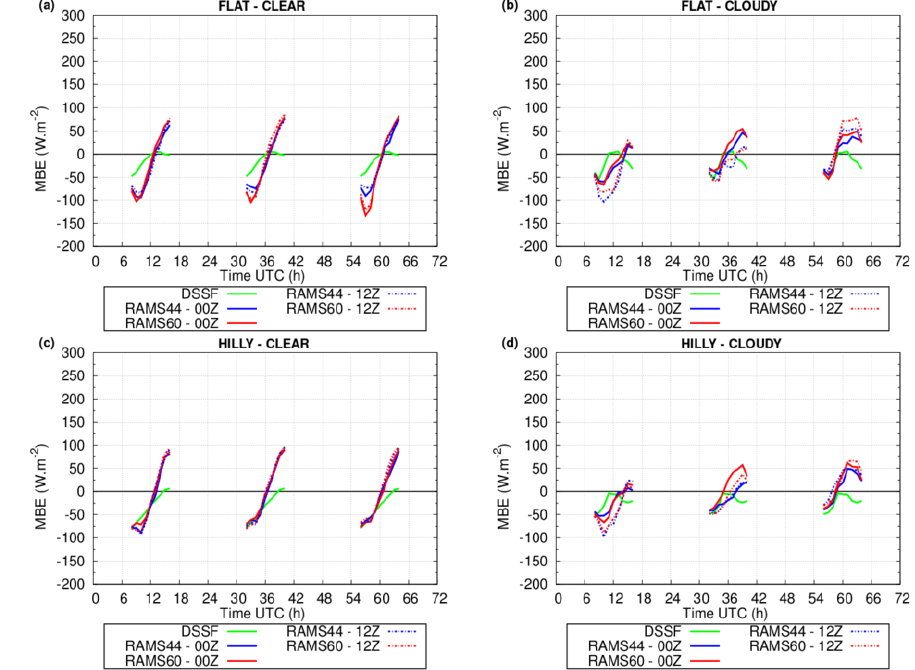
Figure 7. Same as Figure 6, but during the winter 2010–2011: flat-clear ( a ); flat-cloudy ( b ); hilly-clear ( c ) and hilly-cloudy ( d ).